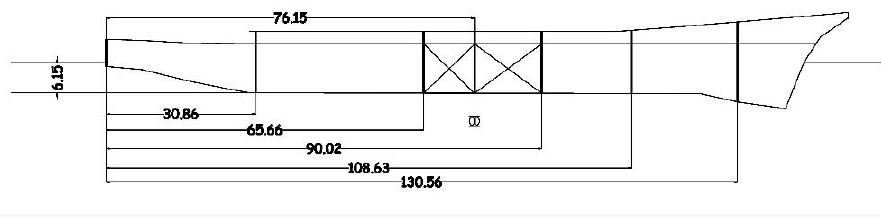
Figure 10. DTMB5415 subdivision and flooded compartment definition—dimensions are in ship scale. Table 3. Main particulars of the DTMB5415 (ship and model scale).